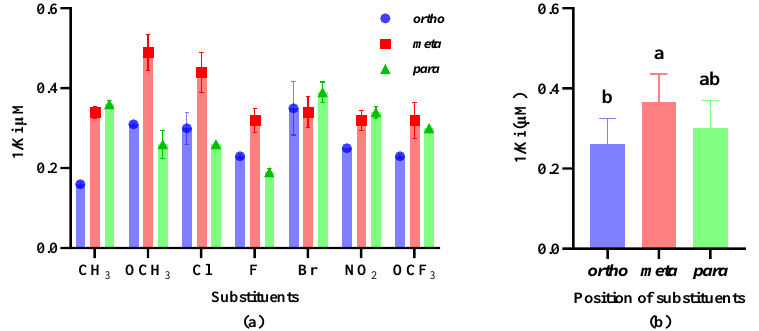
Figure 4. ( a ) The order of the binding affinity of monosubstituents with ApisOBP9; ( b ) The positional effects of ortho -, meta- , and para- substituents on binding affinity. Data represent the mean ± standard deviation. A one-way analysis of variance (ANOVA) was performed followed by Duncan’s test (Different letters indicate values are significantly different ( p < 0.05)).